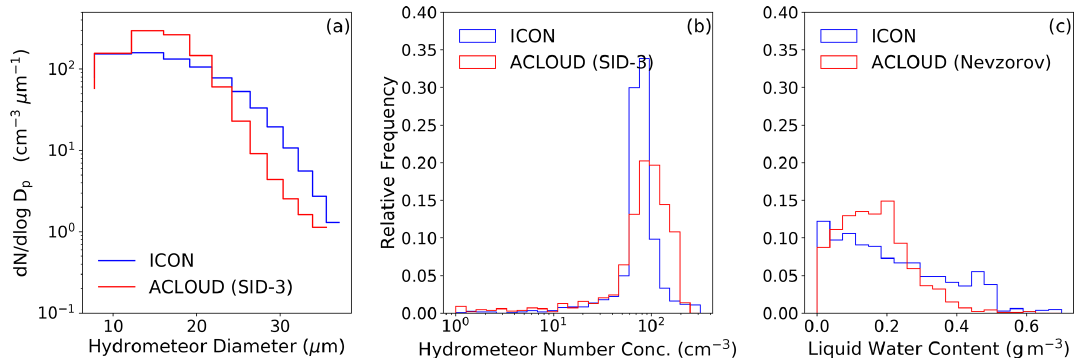
Figure 8. Same as Fig. 7 but with a scaled number of activated CCN by a factor of 0.4. Due to different cloud fields in this simulation, the red lines (ACLOUD) are not identical with Figs. 6 and 7 because of the sampling strategy employed as only datapoints in the observations and the simulation are being used if both are within a cloud